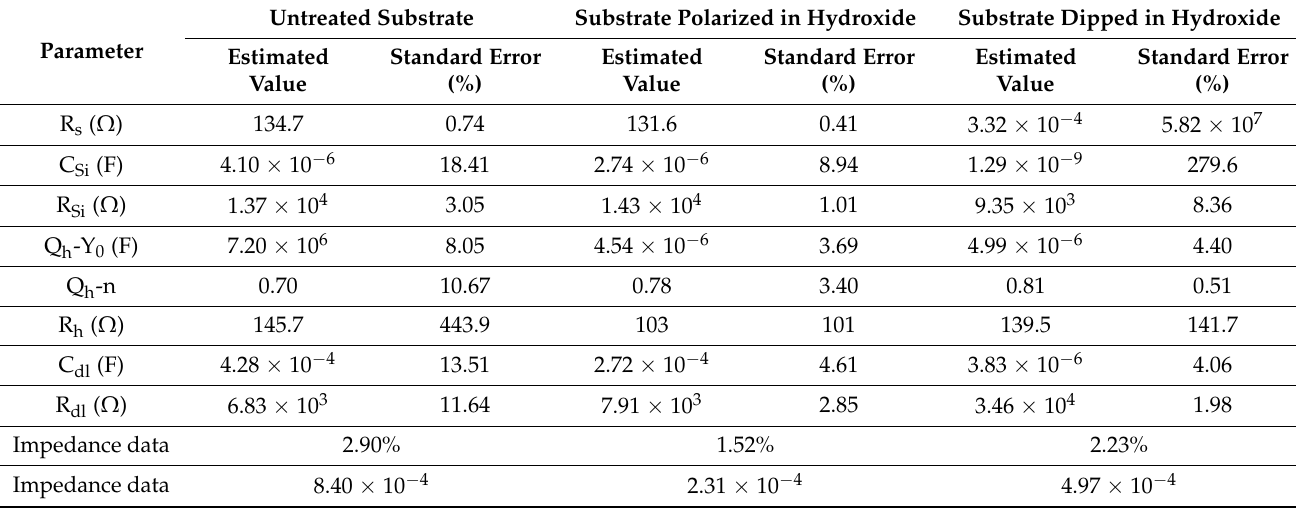
Table 2. Corrosion of BTSE coated AZ91D, untreated, polarized in hydroxide and dipped in hydroxide, after immersion in 0.1 M NaCl solution: Calculated parameters for components in Model R s (C Si R Si (Q h R h ))(C dl R dl ). Untreated Substrate Substrate Polarized in Parameter